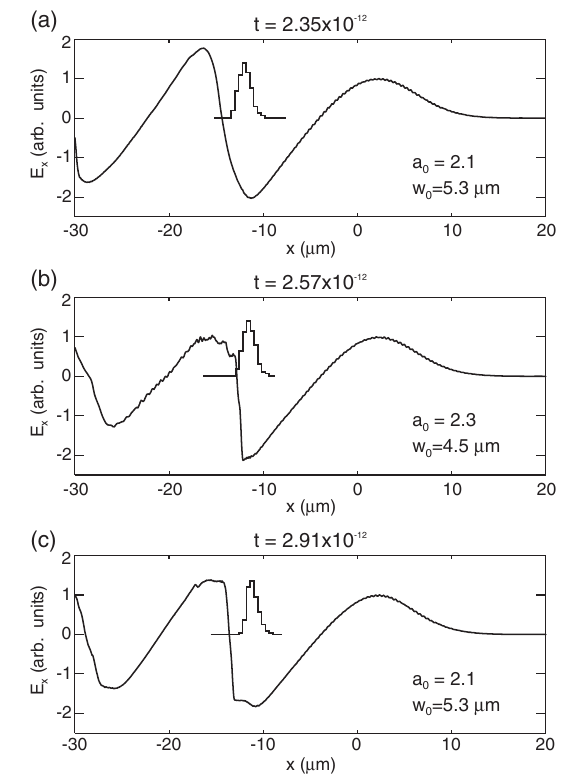
FIG. 4. Longitudinal electric field (on axis) at different times and histogram density (integrated over the transverse dimension) of the trapped electron